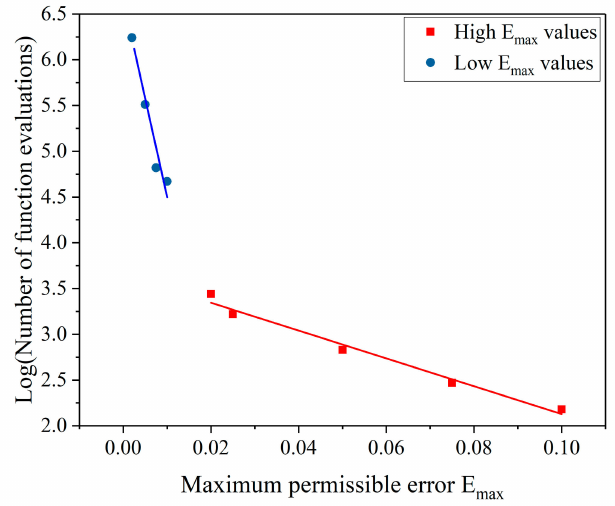
Figure 7. Number of ANN evaluations required for SA to obtain certain maximum permissible